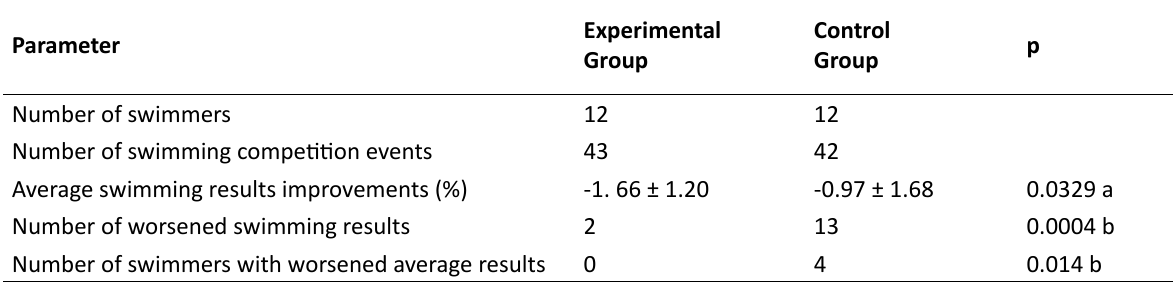
Table 2. Changes of competition results of the swimmers in this